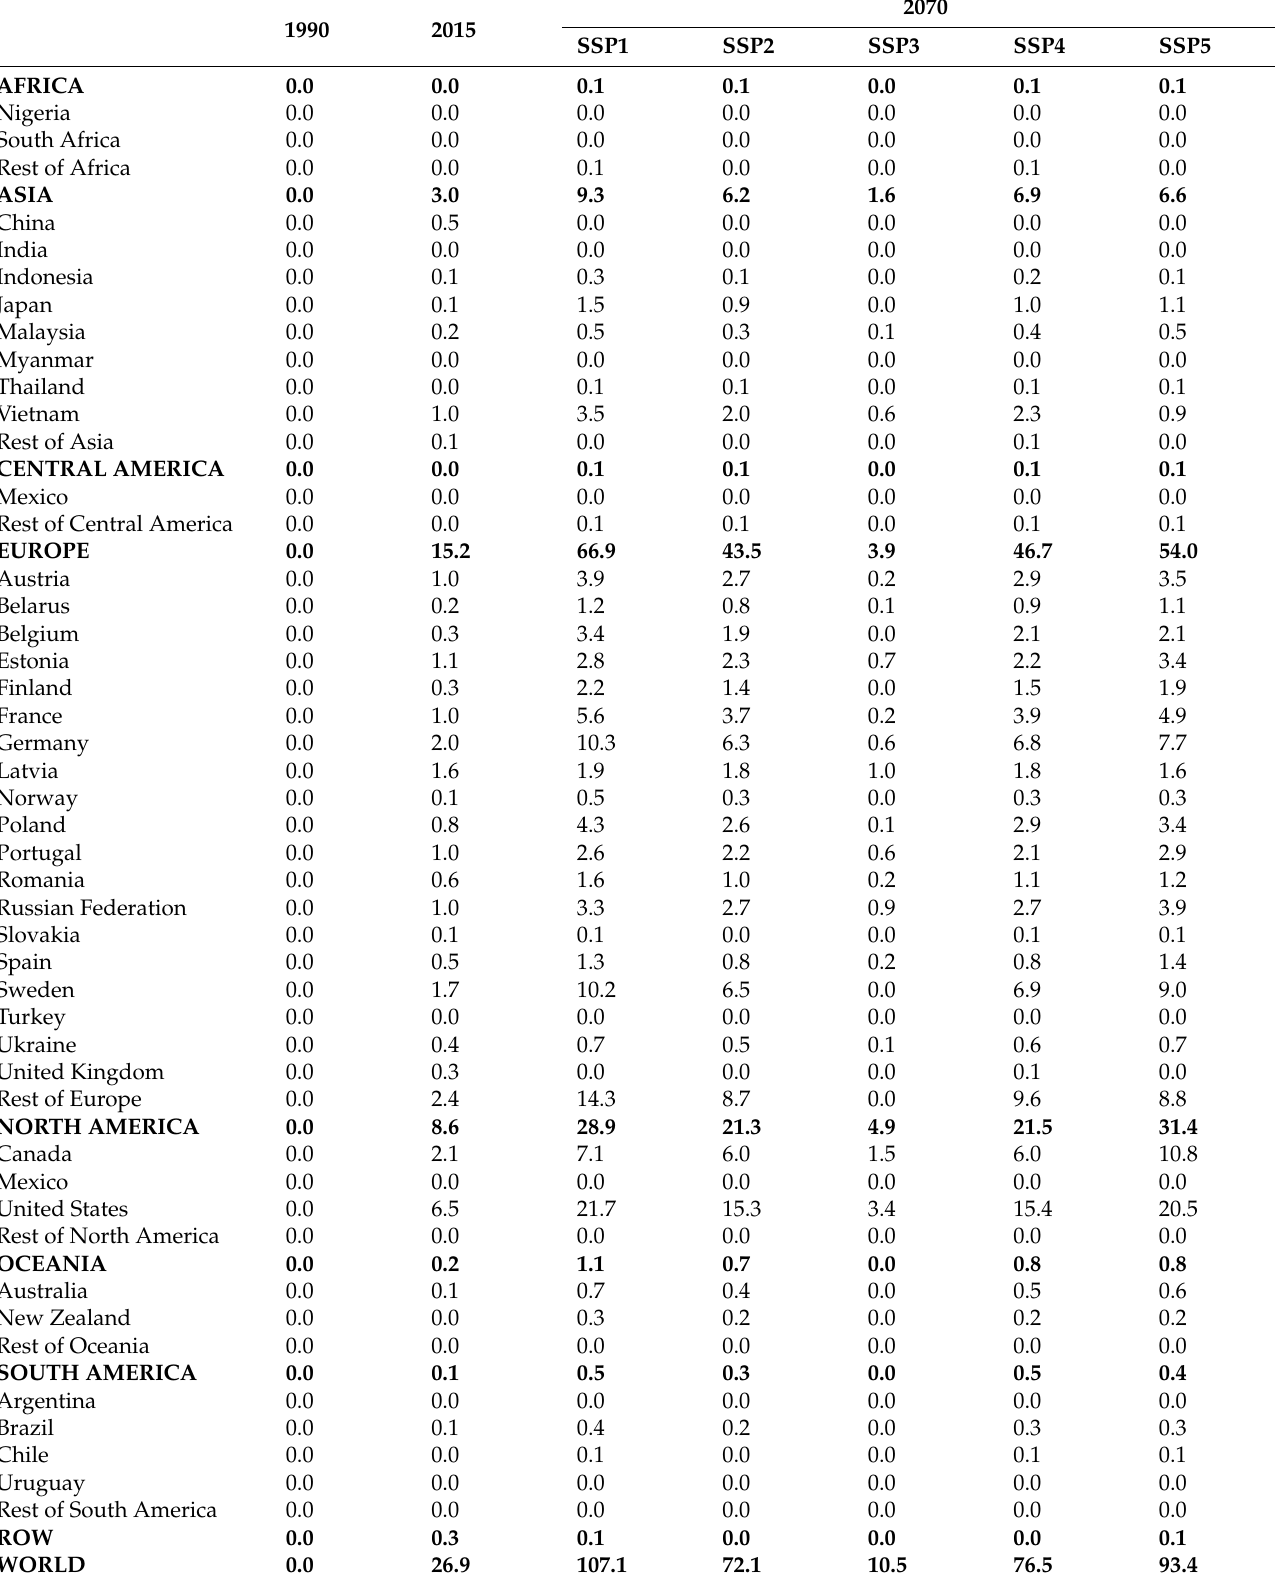
Table A5. Wood pellet production (million metric tons), 1990 to 2015 historic, 2070 projections from